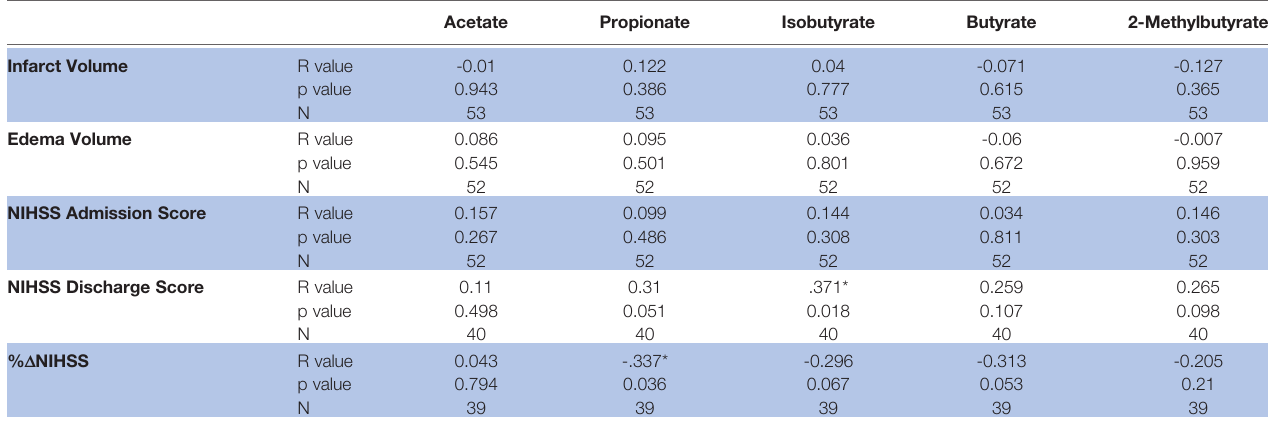
TABLE 3 | SCFA pearson correlations with stroke parameters.